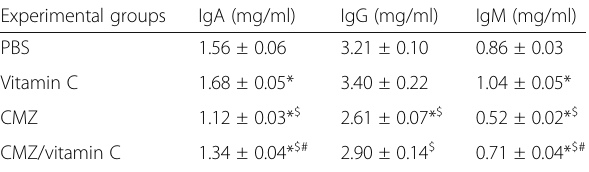
Table 7 Changes in the level of serum total protein of male Swiss albino mice treated with PBS, vitamin C (1136 μ M/kg), CMZ (46 μ M/kg), or a combination of CMZ and vitamin C with the same dose of each intraperitoneally (i.p.) daily over 4 weeks